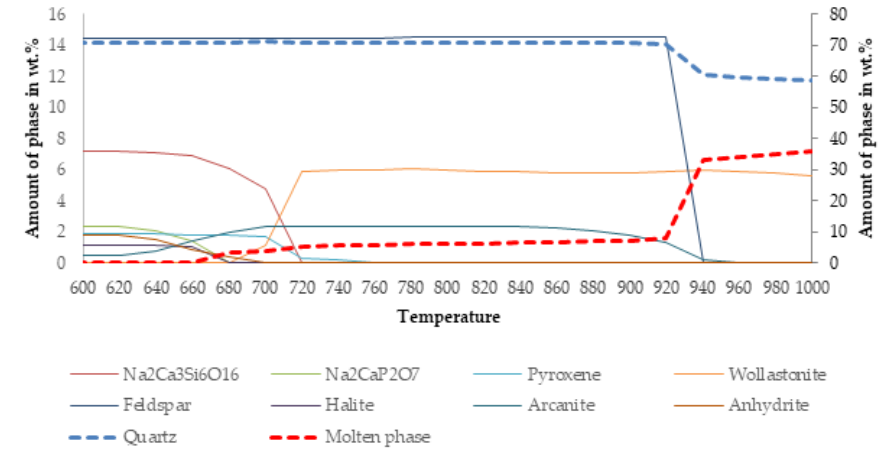
Figure 8. Equilibrium calculation based on composition of coherent ash residues from the gasification experiment in the 100 kW DFB pilot plant.